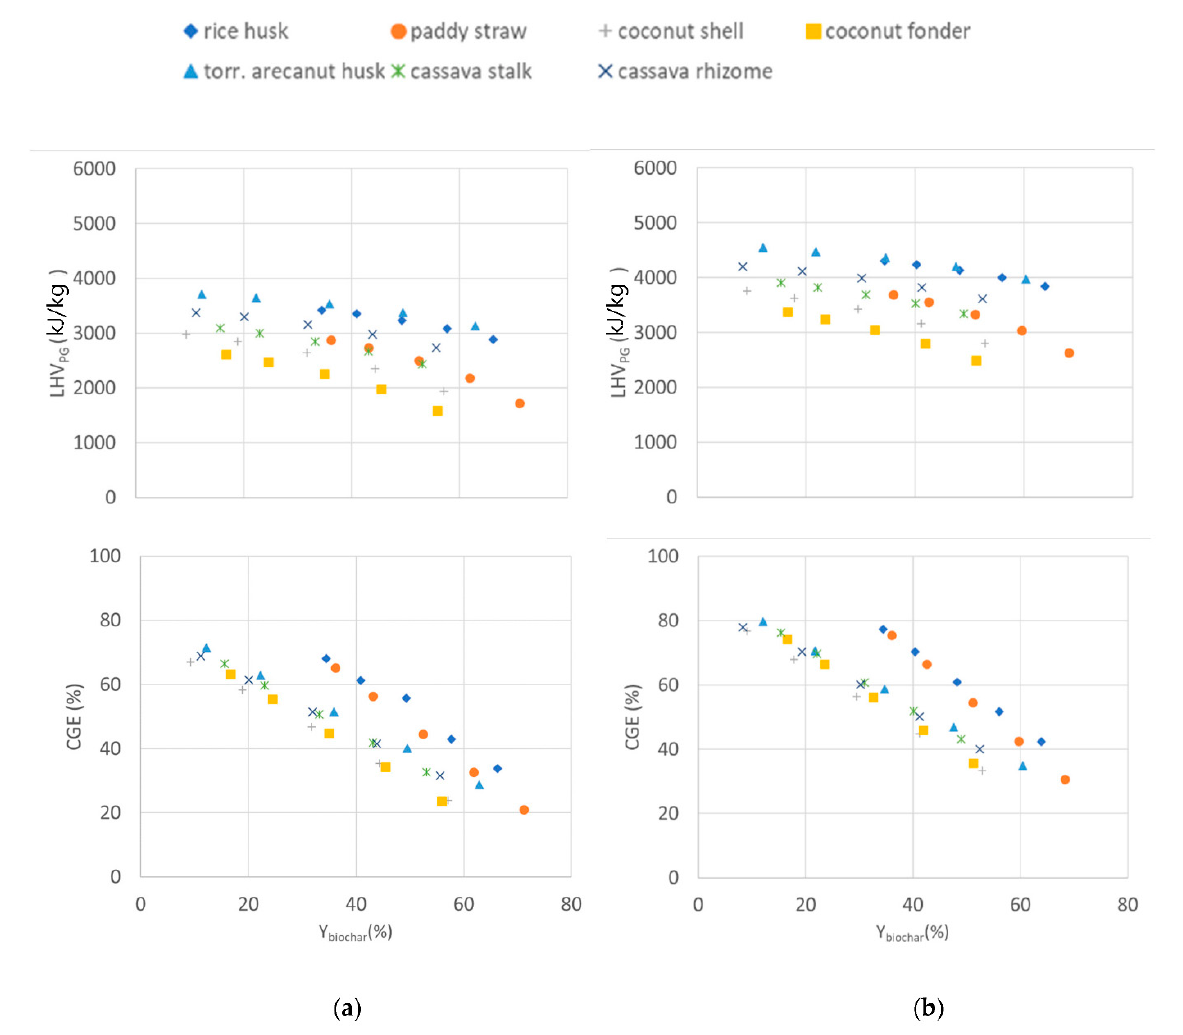
Figure 7. LHV PG and CGE depending on Y biochar : ( a ) two ‐ reactor model, ( b ) three ‐ reactor model.